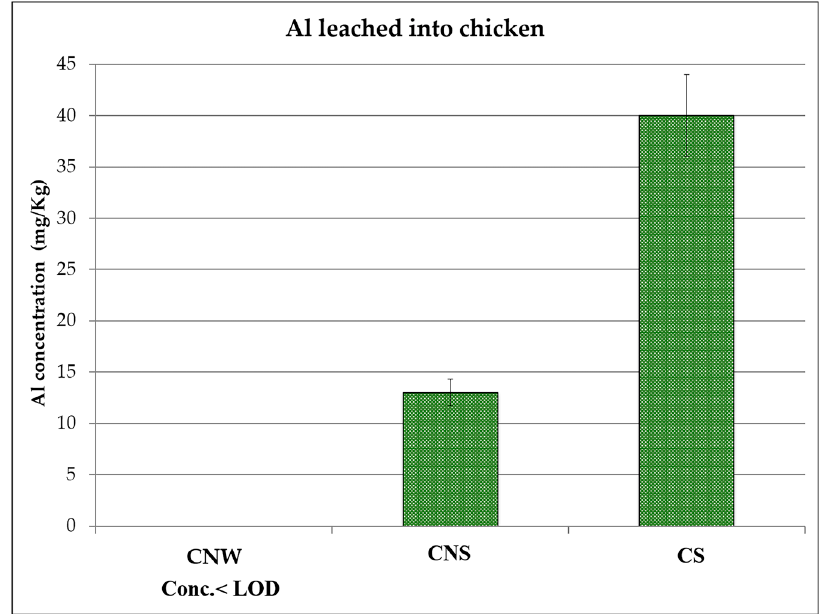
Figure 2. Aluminum concentration detected in chicken baked without wrapping in aluminum foil (CNW), chicken baked in aluminum foil without seasoning (CNS), and chicken baked in aluminum foil with some seasoning (CS). LOD: limit of detection.